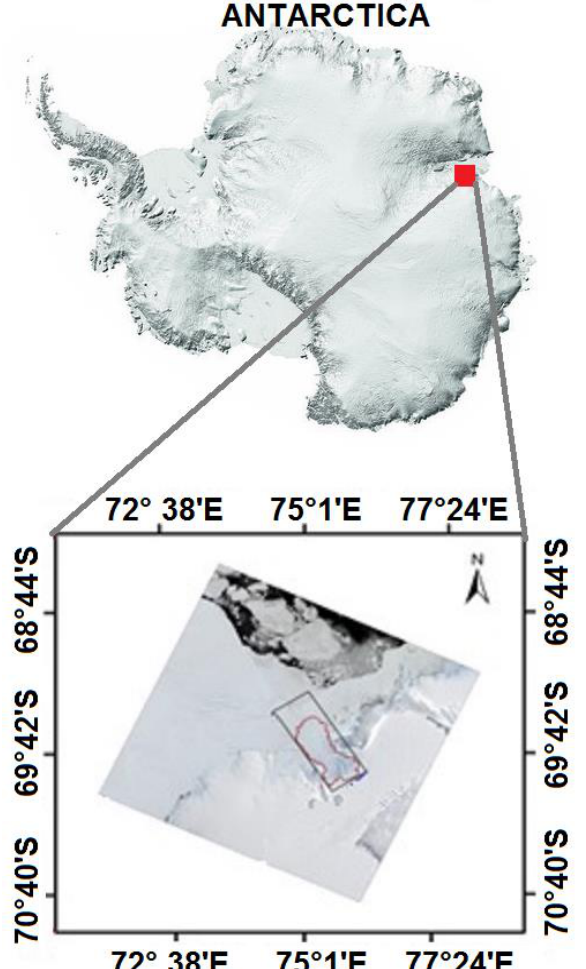
Figure 1: Geo-location of Polar Record Glacier, East Antarctica (top) and Landsat-8 imagery depicting the position and extent of the glacier